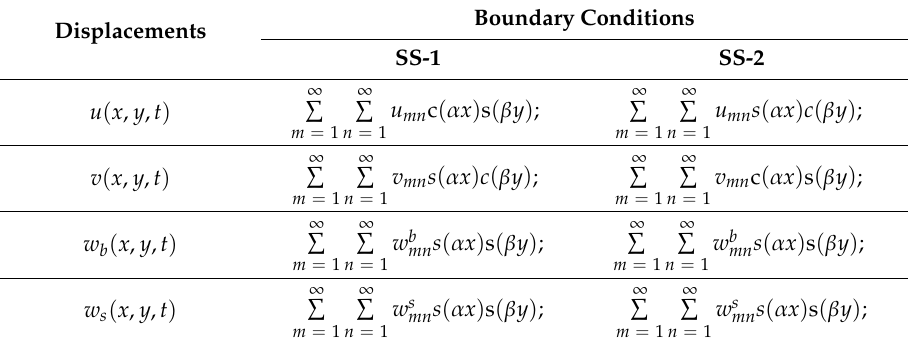
Table 3. The expansion displacements ( u , v , w b , w s )